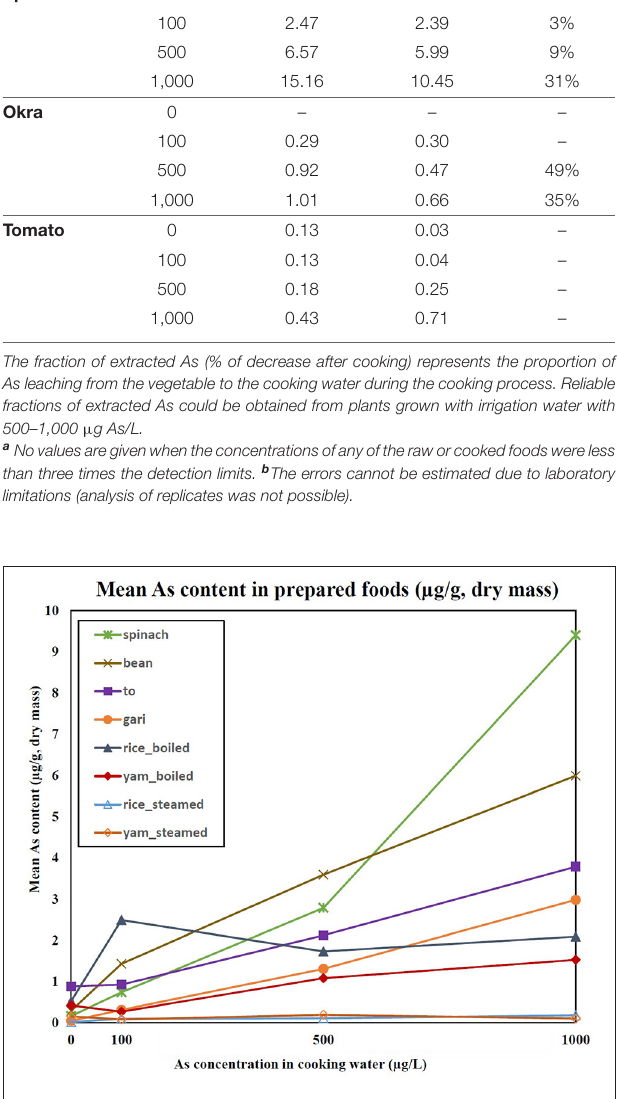
FIGURE 3 | Mean As content in prepared foods ( µ g/g, DM) as a function of As concentration in cooking water ( µ g/L). Errors bars are given in Supplementary Table 6